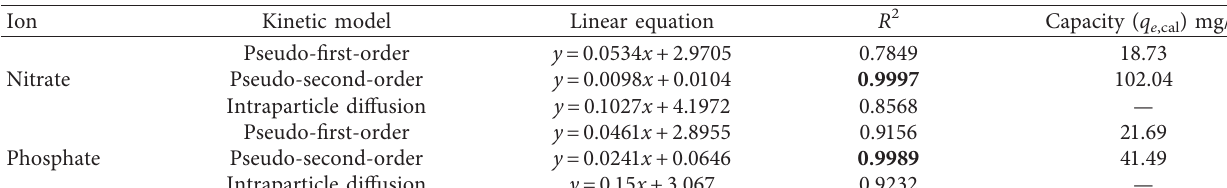
Table 1: Correlation coefficients ( R 2 ) and linear equations of kinetic models for nitrate and phosphate adsorption on ferric oxide-amine material.